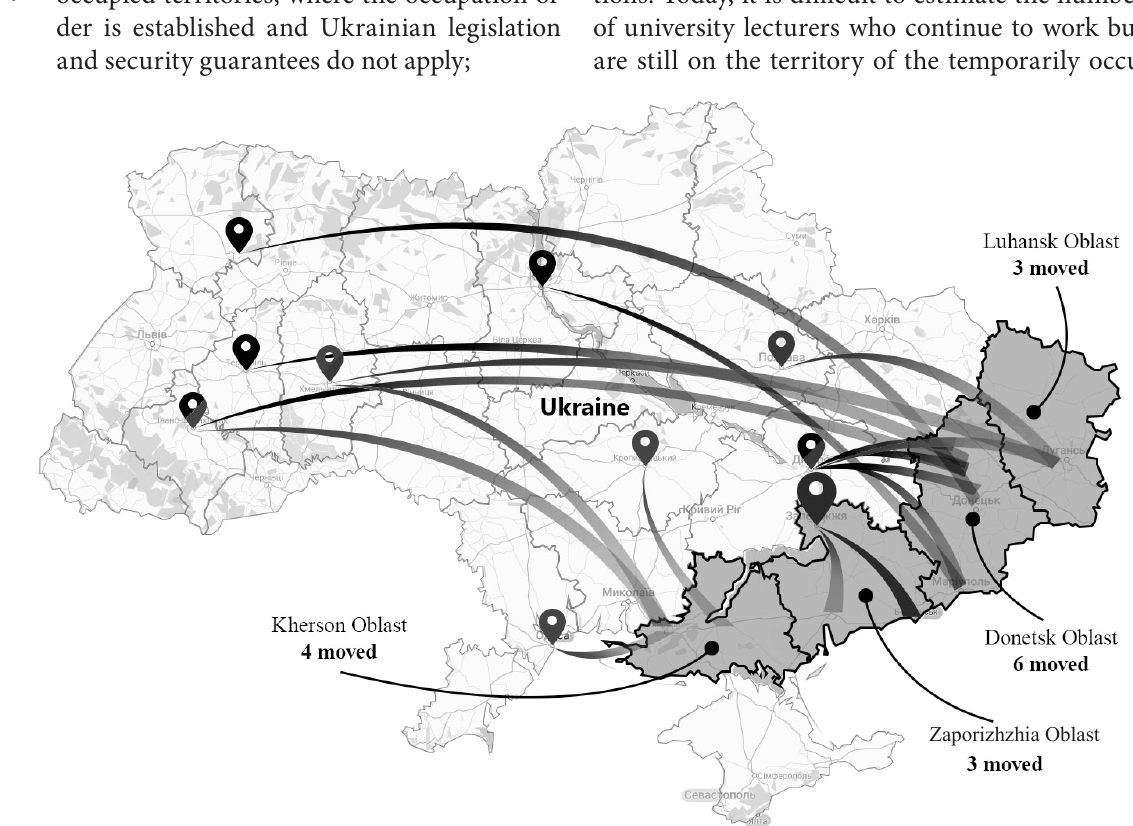
Figure 5. Map of displaced universities in